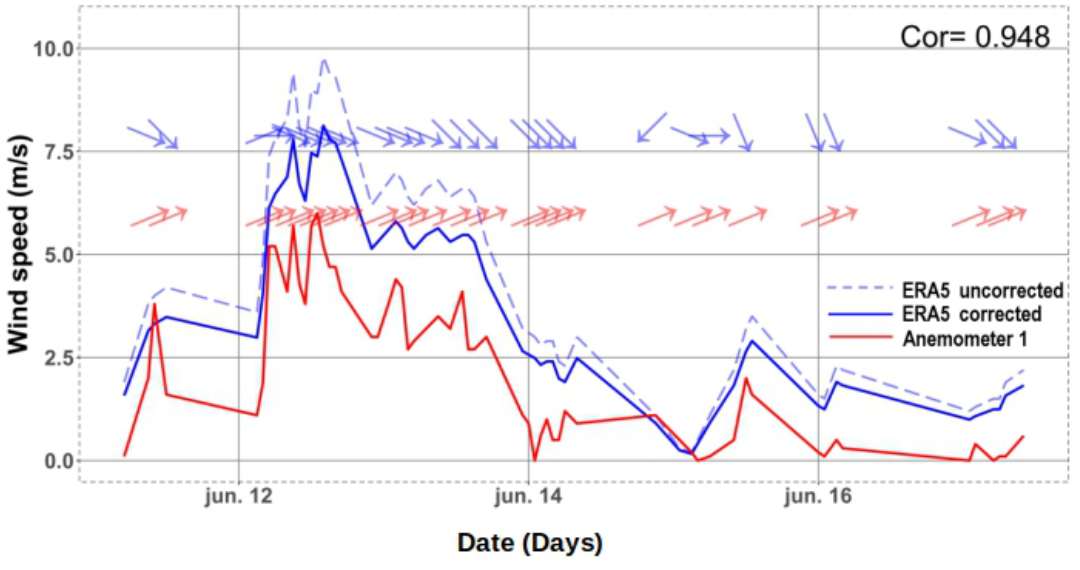
Figure 12. Wind speed of nearest ERA5 grid point (blue) and anemometer (red) during a week of June. In addition, wind direction vectors are represented in the